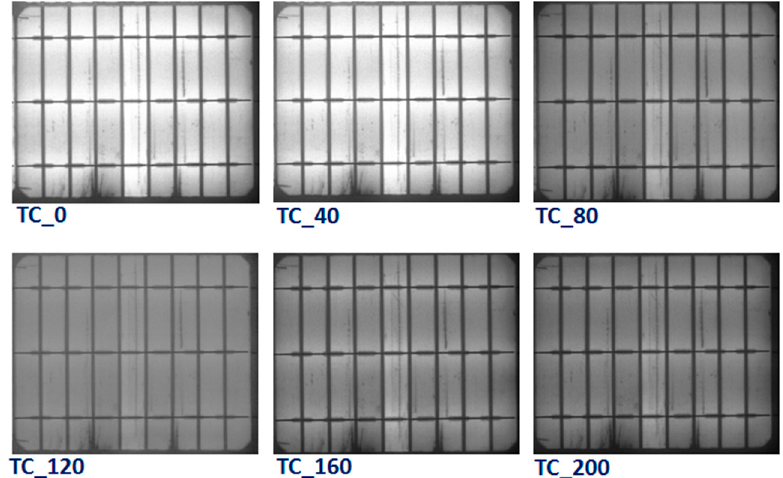
Figure 7. Electroluminescence images of PV modules without concrete after various thermal cycling tests (0, 40, 80, 120, 160, and 200 cycles).